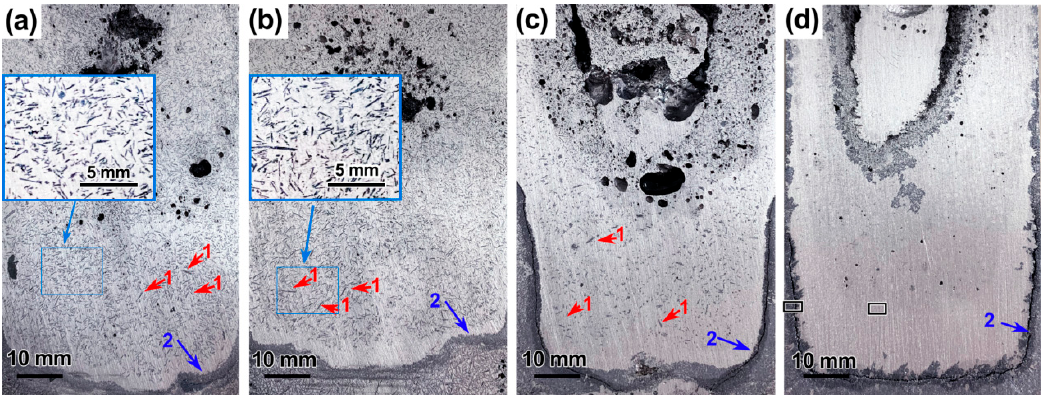
Figure 6. Vertical-sections of Al-30Si alloys solidified by starting RMF at temperatures of ( a ) 700 °C, ( b ) 730 °C, ( c ) 760 °C, ( d ) 790 °C.